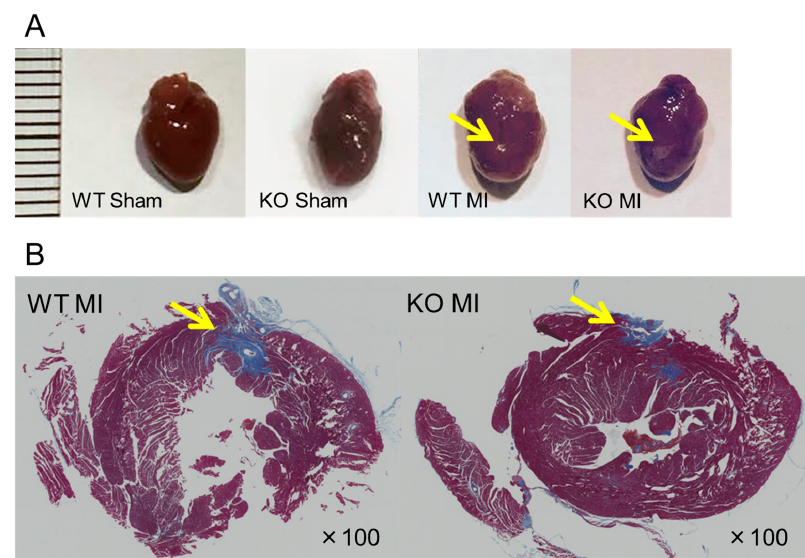
Figure 4. Representative hearts from sham-operated and left anterior descending artery ligated mice. Whole hearts ( A ) and microscopic findings ( B ) of the infarcted regions are shown (arrows). Sections stained with Masson’s trichrome stain ( B ) are shown by ×100 magnification under light microscopic examination using a BZ-9000 fluorescence microscope (Keyence, Osaka, Japan). The ruler shows millimeter markings. WT: wild-type, KO: knockout, MI: myocardial infarction.